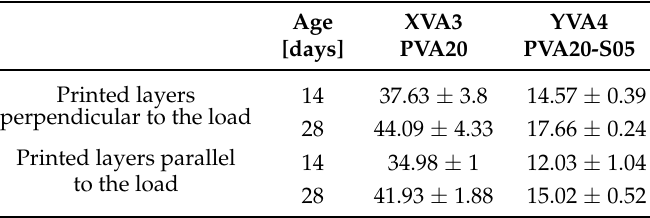
Table 2. Compressive strength of printed samples